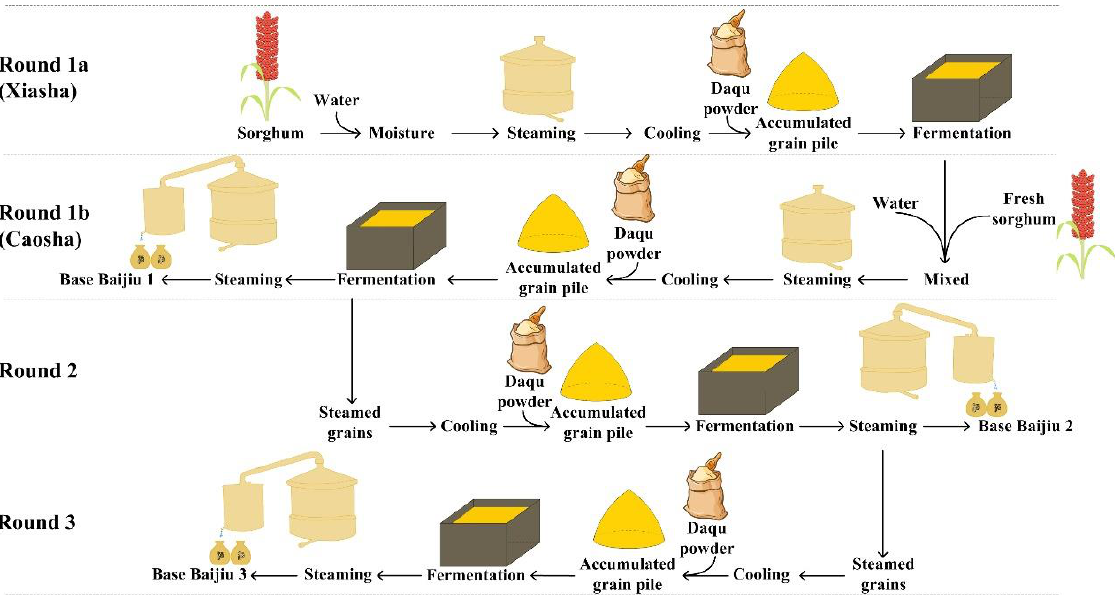
Figure 1. The first three rounds of the fermentation process of sauce-flavor Baijiu. The sensory evaluation shows that there are divergent flavors of the seven-base Baijius. The base Baijiu from the first and second rounds shows a light flavor and without the typical sauce flavor [3,7]. The base Baijius produced by the third, fourth, and fifth rounds